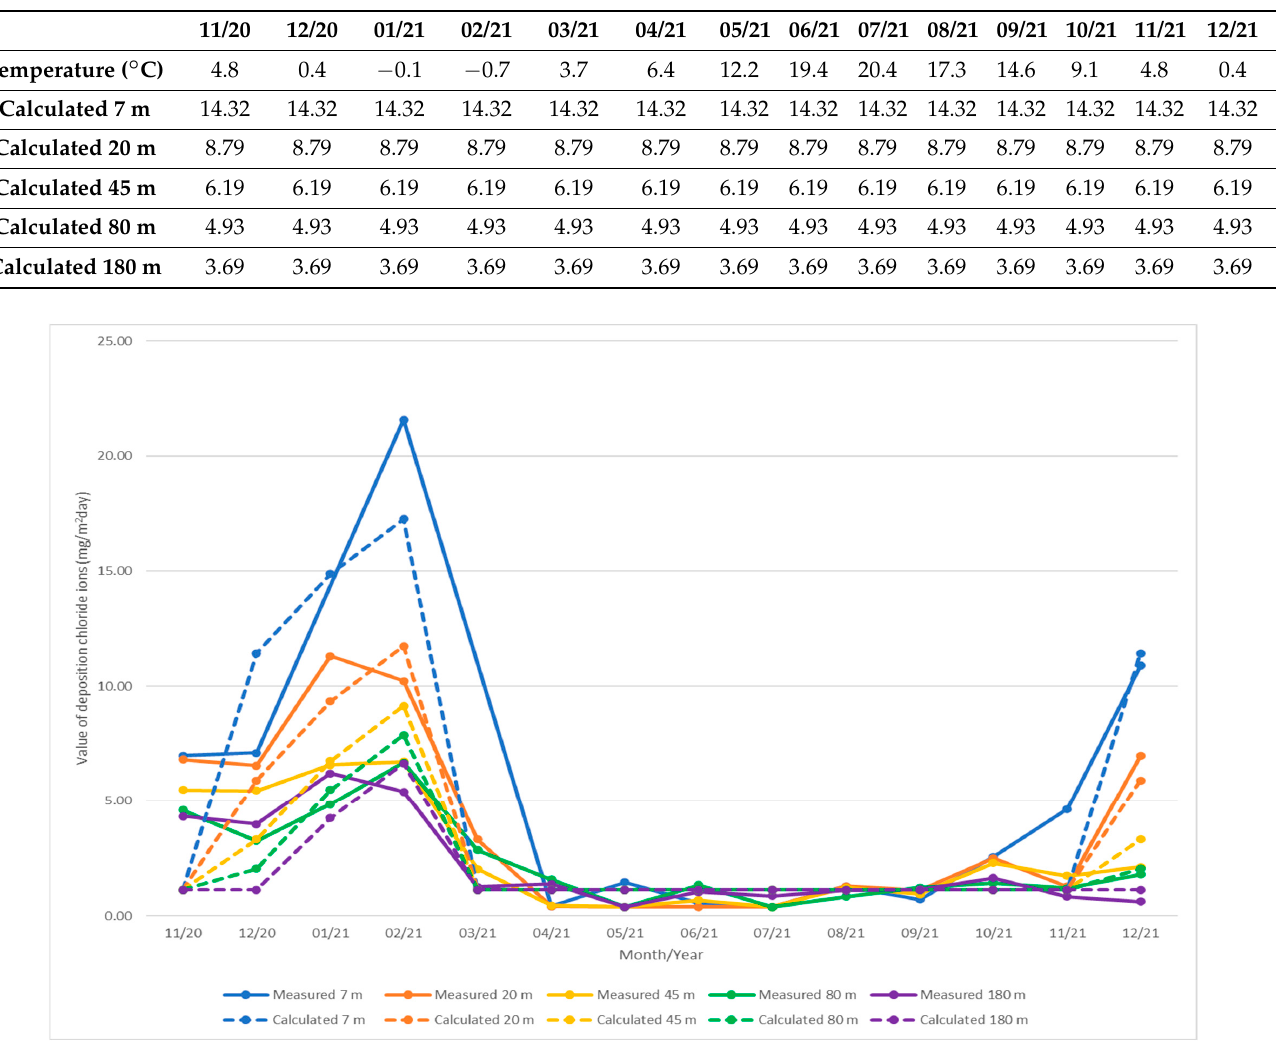
Figure 7. Graphical representation of the measured and calculated values of deposition of chloride ions (mg/m 2 day).